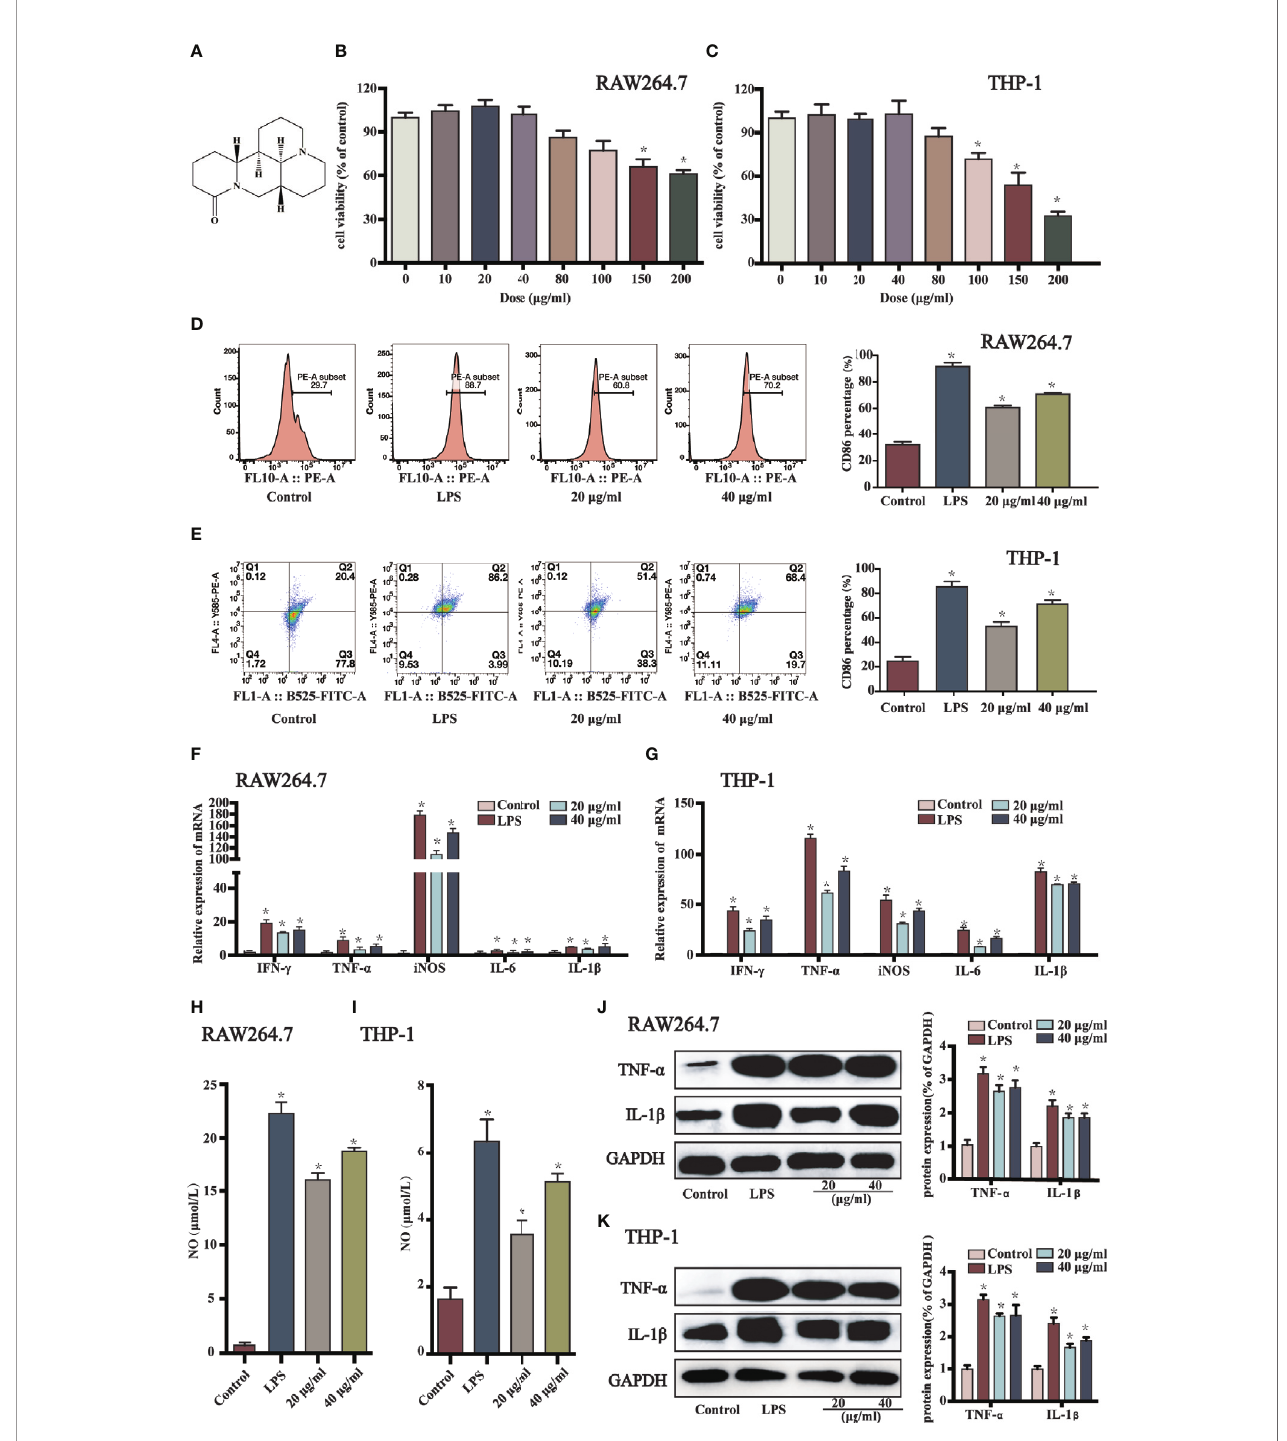
FIGURE 1 | Sophoridine promoted macrophages shifting to M1 phenotype. (A) Chemical structure of sophoridine (downloaded from PubChem). (B, C) The cell viability of sophoridine-stimulated RAW264.7 and THP-1-derived macrophages was detected by CCK-8 assay. (D, E) The percentage of CD86 of RAW264.7 and THP-1-derived macrophages. (F, G) The relative expression of IFN- g , TNF- a , IL-6, iNOS, and IL-1 b mRNA in RAW264.7 and THP-1-derived macrophages determined by RT-PCR. (H, I) The NO production of RAW264.7 and THP-1-derived macrophages assessed by Griess. (J, K) The protein expression (% of GAPDH) of TNF- a and IL-1 b in RAW264.7 and THP-1-derived macrophages determine by Western blotting (n = 3), p < 0.05